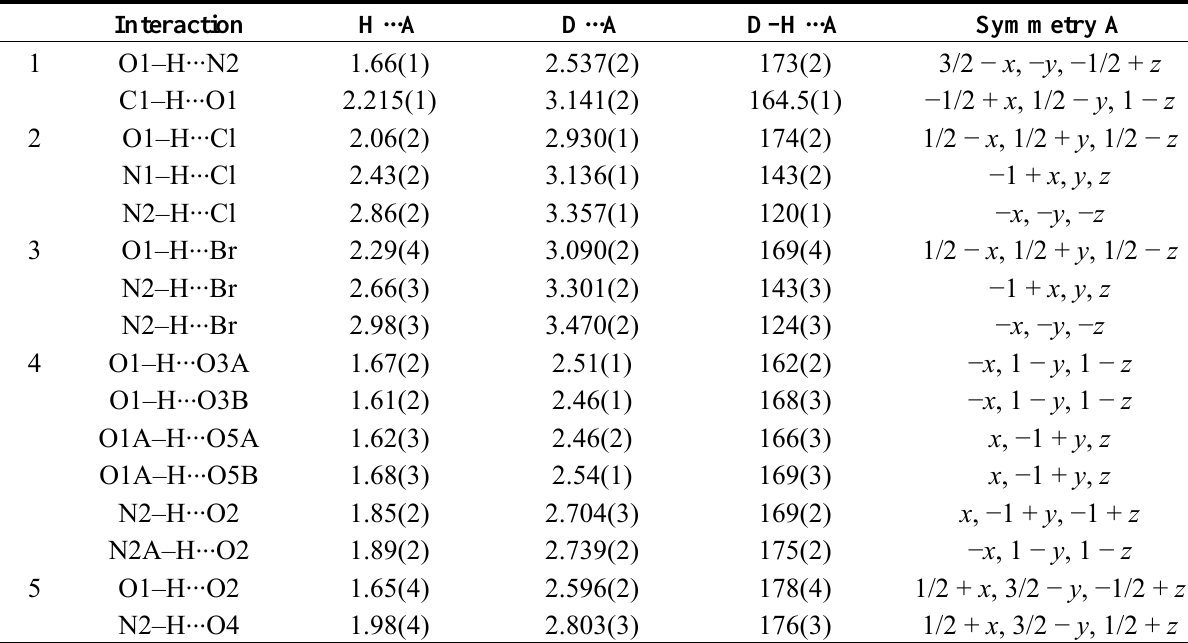
Table 2. Hydrogen bond parameters